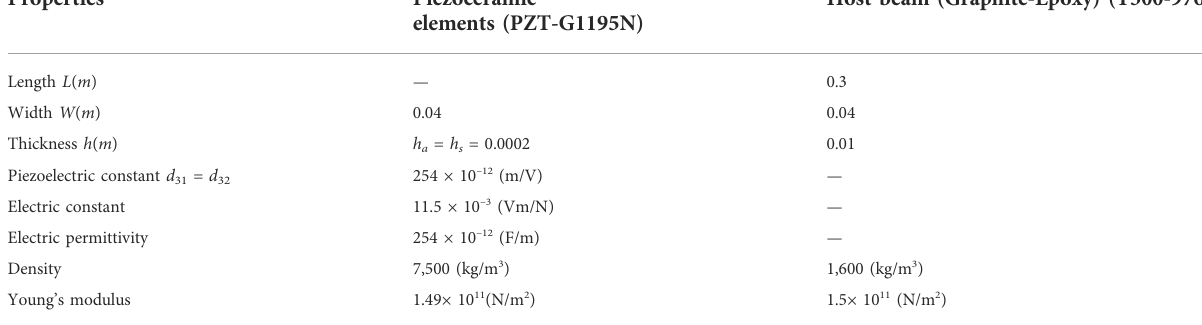
TABLE 1 Material and physical properties of piezoelectric elements and the host beam. Properties